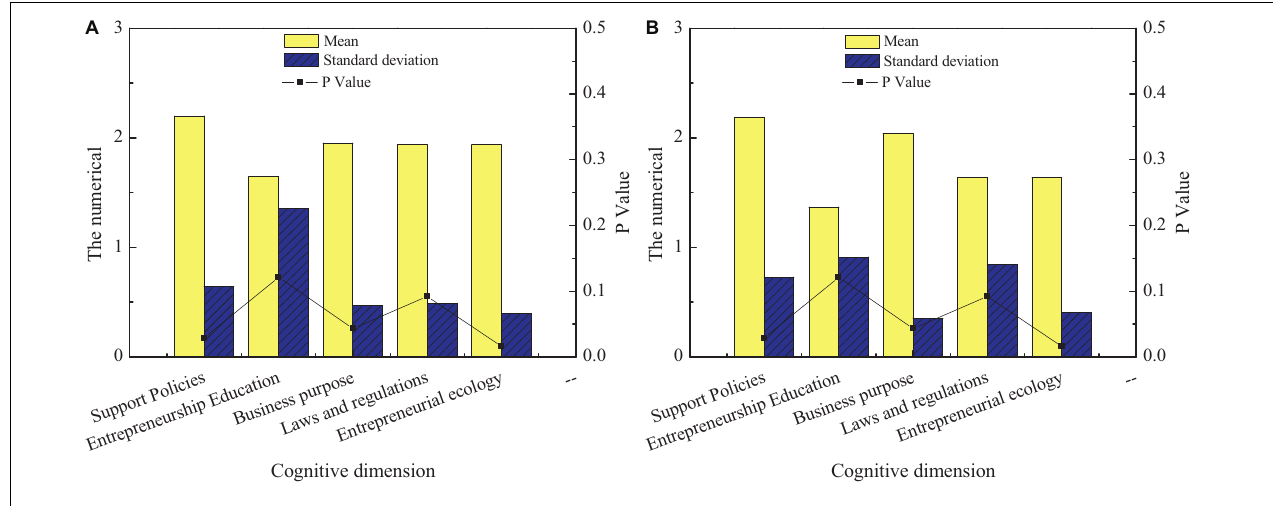
FIGURE 4 | Differences in entrepreneurial cognition of intangible cultural heritage among students of different genders: (A) men and (B) women.